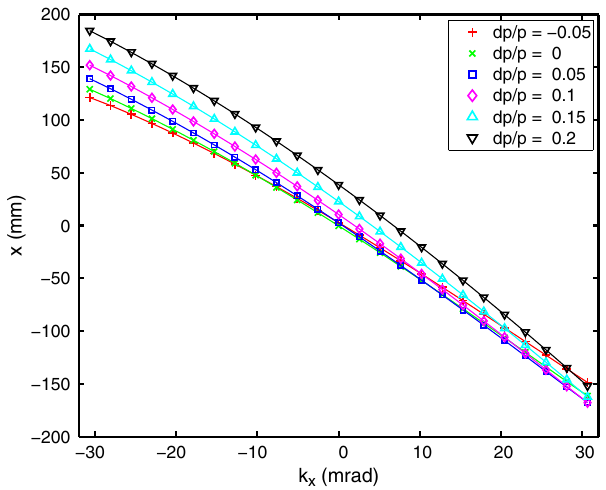
FIG. 16. In-plane offset of the beam center at the isocenter as a function of in-plane sweeper scan angle at different momentum deviations.